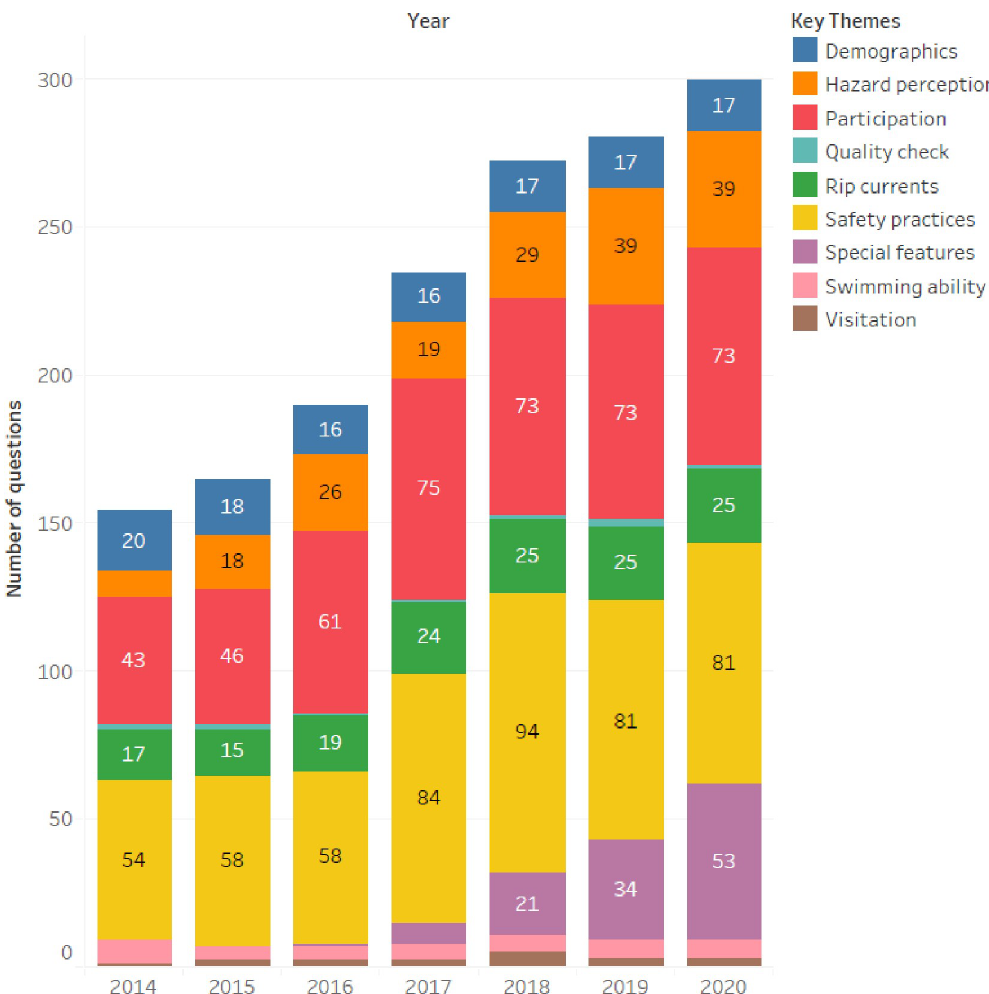
Fig 3. Structural proportions of the surf life saving Australia national coastal safety survey illustrating the themes and number of questions within each survey. NB: Not all respondents are required or eligible to answer all questions, and while the number of questions have doubled since 2014, the survey length (minutes) has only increased by 40% (4.5